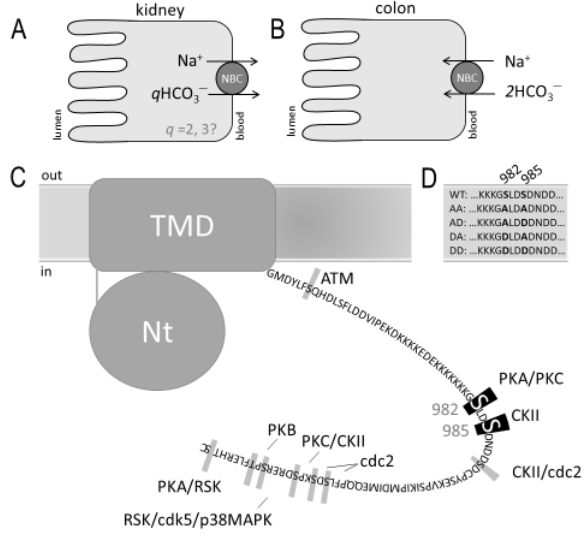
Figure 1. Predicted phosphorylation sites in the cytoplasmic C-terminus of NBCe1. ( A ) The mode of action of NBCe1-A in the basolateral membranes of renal proximal tubule epithelia. HCO 3 − is generated in the cytosol by ammoniagenesis and the action of carbonic anhydrase II; ( B ) The mode of action of NBCe1-B in the basolateral membranes of colonic crypt epithelia. The process of HCO 3 − secretion into the lumen is completed via numerous apical anion transporters and channels [13]; ( C ) Graphic representation of NBCe1-A showing the cytoplasmic amino (Nt) and carboxy (Ct) terminal domains in relation to the transmembrane domain (TMD). Ct is not shown larger than scale in order to present the primary sequence. Highlighted residues were predicted to be phosphorylated (probability > 0.5) by the NetPhos 3.1 server (http://www.cbs.dtu.dk/services/NetPhos/, accessed on 24 February 2021). Black highlighted residues 982 and 985 were demonstrated to be phosphorylated by a phosphoproteomic study of rat kidney cortices [14]. ATM = ATM kinase. PKA, PKB, PKC = protein kinases A, B, and C. cdc2 = cyclin-dependent kinase 1. cdk5 = cyclin-dependent kinase 5. CKII = casein kinase II. p38MAPK = p38 mitogen-activated kinases. RSK = ribosomal S6 kinases; ( D ) The sequence of mutant clones studied in the present